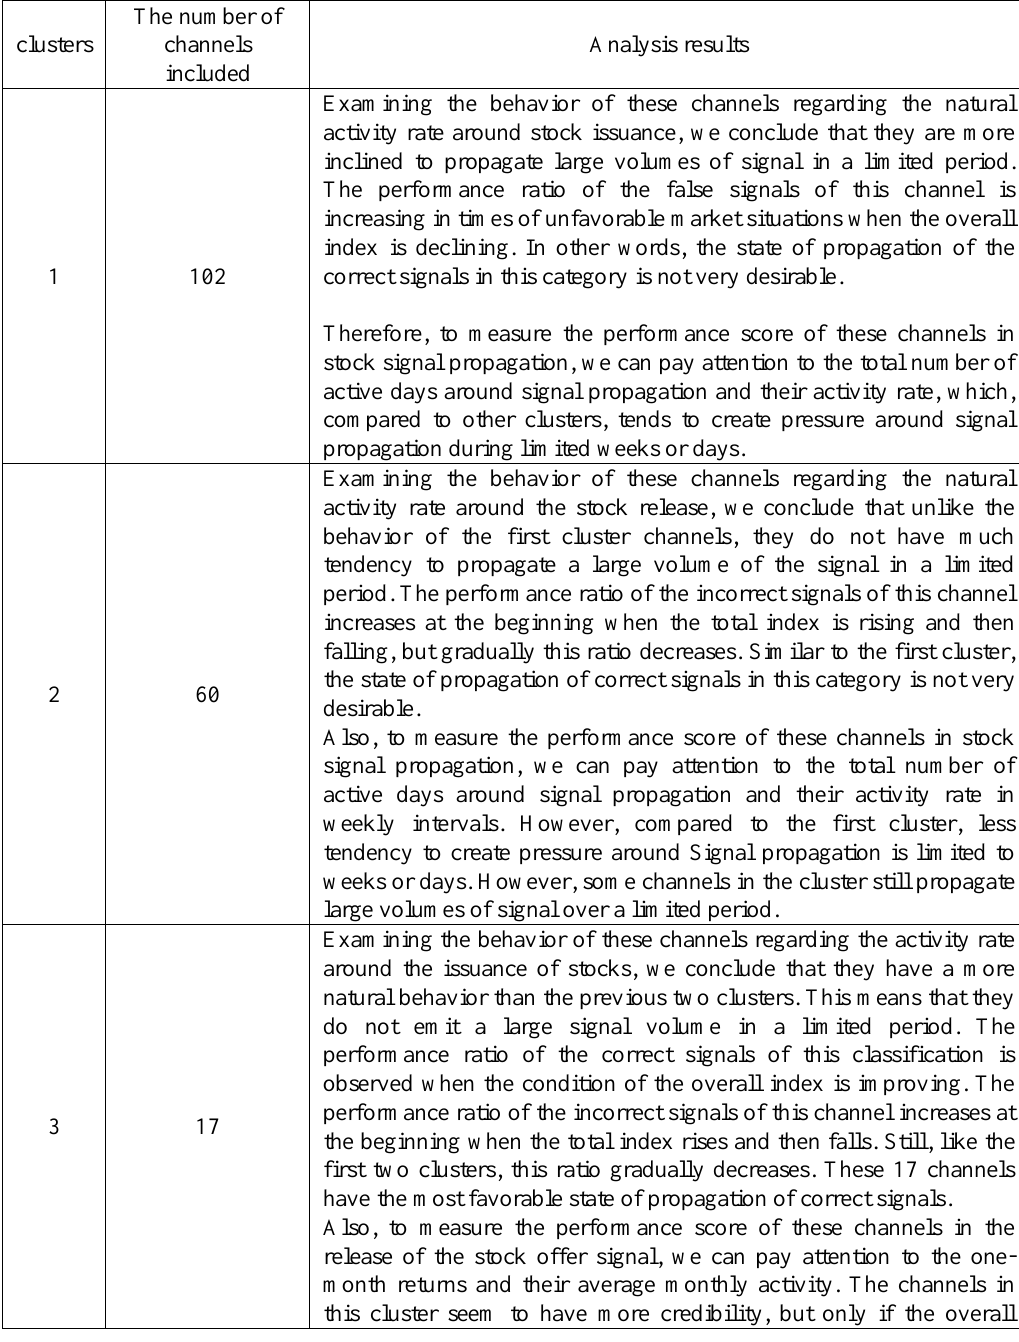
Table 5. Channels